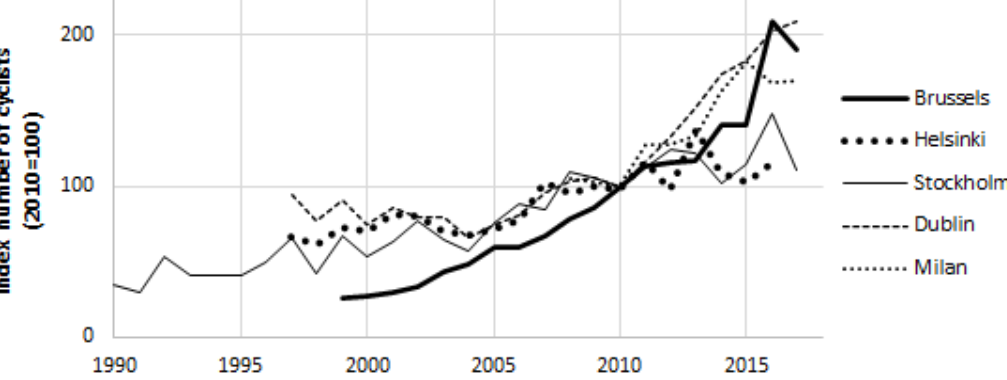
Figure 6. Index (2010=100) of numbers of cyclists counted at fixed locations in city